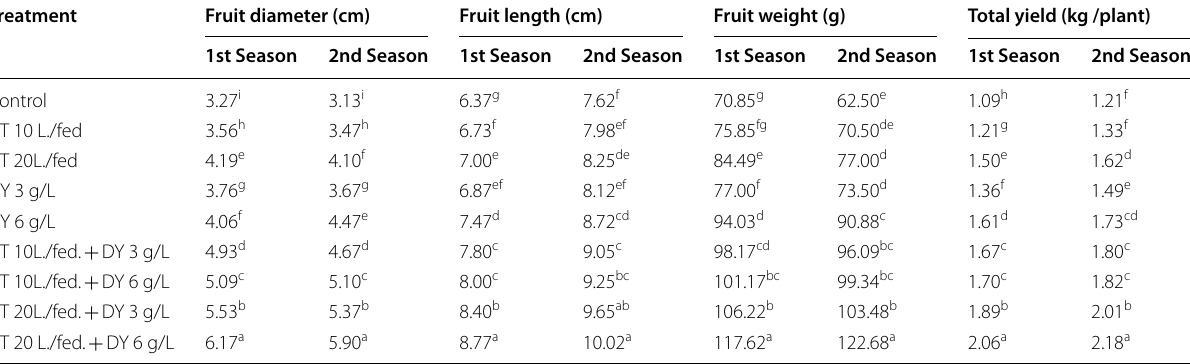
Table 8 Effect of compost tea, dry yeast and their mixture on fruit physical quality and total yield of sweet pepper during